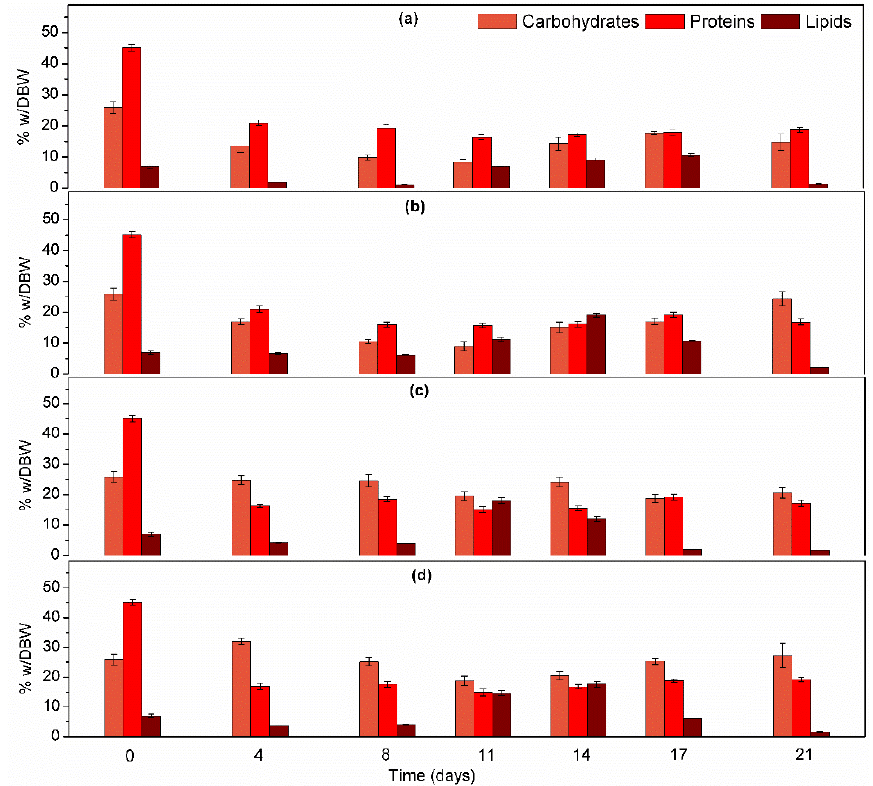
Figure 3. Carbohydrate, protein, and lipid contents in total biomass during A. platensis cultivation under continuous illumination in ( a ) untreated brewery wastewater, ( b ) brewery wastewater with 1 g/L NaCl, ( c ) brewery wastewater with 5 g/L NaHCO 3 , and ( d ) brewery wastewater with 1 g/L NaCl and 5 g/L NaHCO 3 . Data present mean values of duplicate experiments ± standard